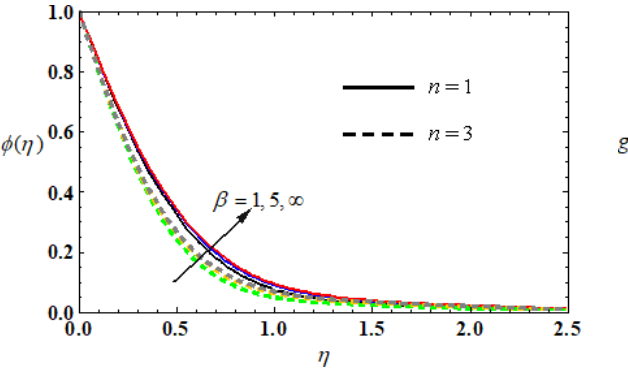
Fig. 5: Influence of β on ϕ ( η )